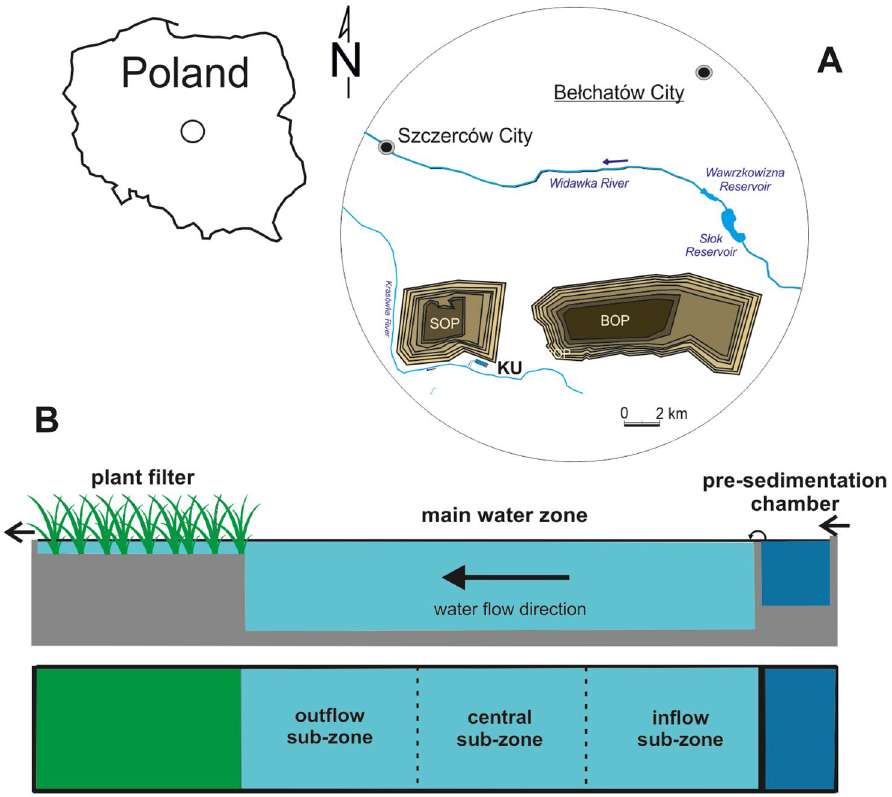
Figure 5. Research site location ( A ) and scheme of the Kuźnica clarification pond in a cross-section ( B ). KU Kuźnica clarification pond, SOP Szczerców open pit, BOP Bełchatów open